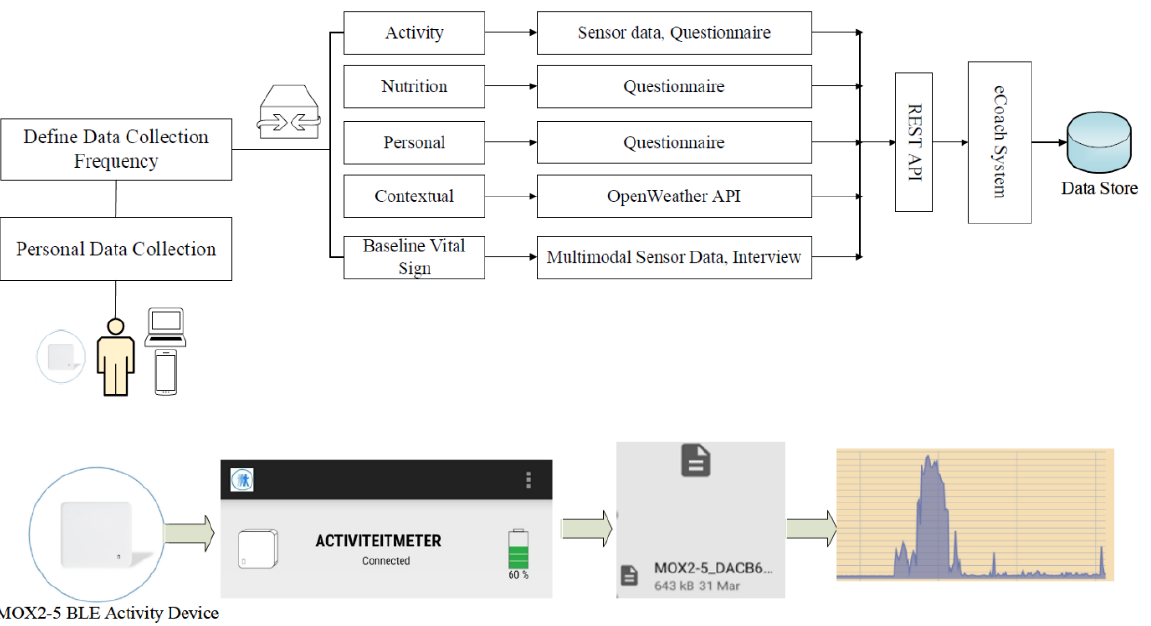
Figure 3. Data collection modules of the health eCoach prototype system.